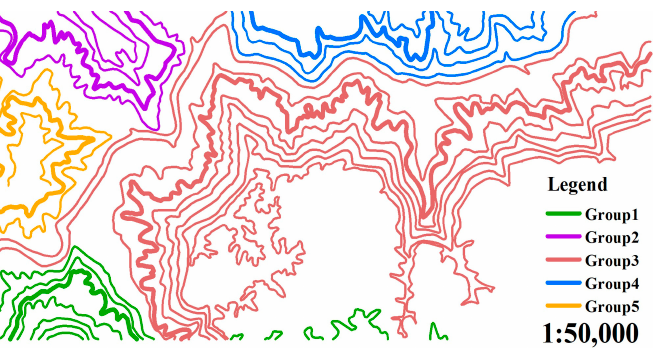
Figure 17. The contour dataset is divided into five groups, with each group assigned a different color. The contours shown in boldface are the reference contours selected from each group. Table 5. Coefficient values of the exponential regression functions in different groups. Table 4. Similarity values between the initial contours and the other scales of contours for reference data in different